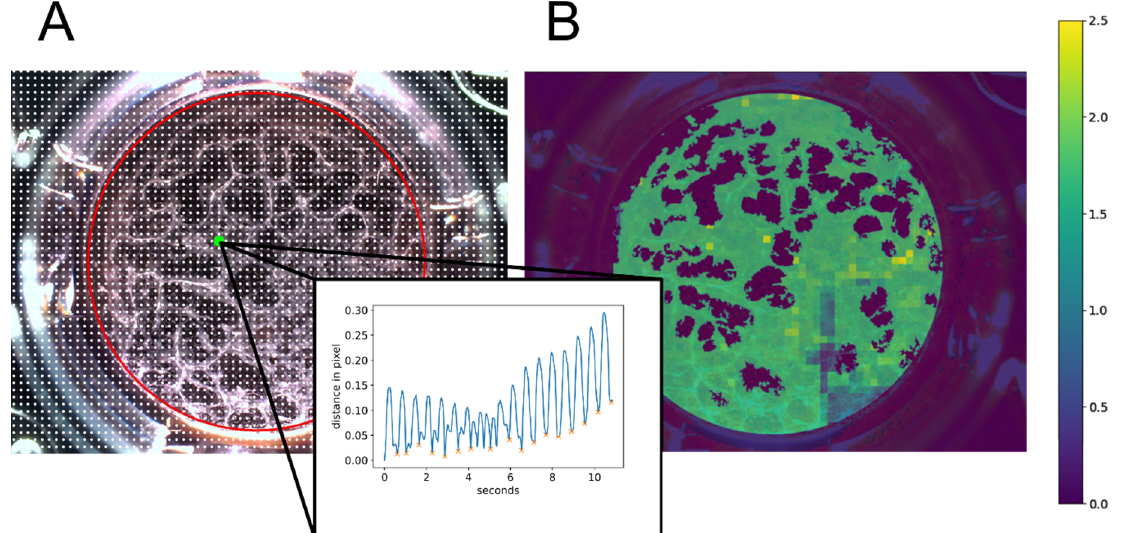
Figure 9. Visualization of video processing steps used in the in-house developed software CardioVision. The software includes different video processing steps to finally determine the beating frequency and beating area of a recorded video. ( A ): Reference points (white dots) were placed over the video in a grid of 20 pixels to each other. Reference points within the region of interest (ROI), depicted as a red circle, were analyzed. The motion profile of a single reference point marked in green is depicted inside the black frame. Peaks marked with an orange X are counted as a beat. ( B ): Heatmap representing the beating area color-coded with the respective beating frequency in beats/second calculated at each reference point.